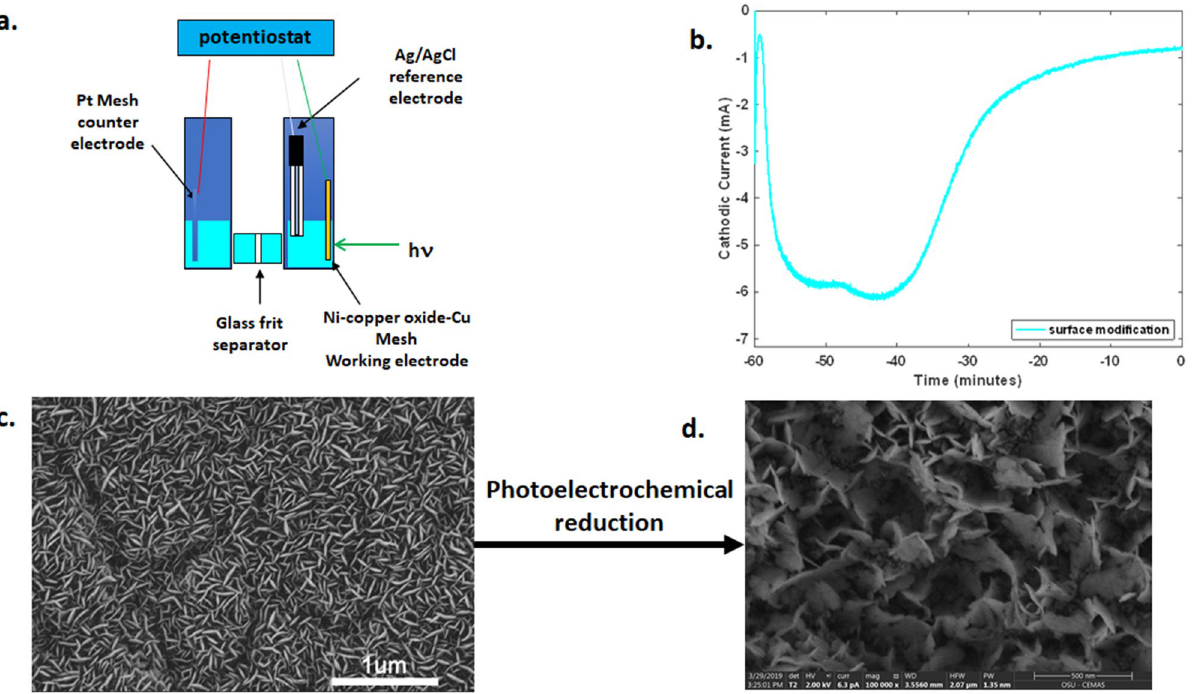
Figure 3. Photoelectrochemical modification of the Ni-copper oxide-Cu surface. ( a ) Schematic of custom quartz H-cell with glass frit separator used for regeneration of NADPH from NADP + , ( b ) Cathodic current versus time in the presence of 532 nm laser irradiation in a 0.5 M sodium phosphate (pH 8) with the electrode at − 0.75 V with respect to a Ag/AgCl (3 M NaCl) reference electrode during the earlier portion of the photoelectrochemical surface modification process, ( c ) SEM of Ni-copper oxide-Cu surface before photoelectrochemical surface modification (same as Fig. 1c), ( d ) SEM of Ni/copper-oxide/Cu surface after photoelectrochemical surface modification. Scale bar = 1